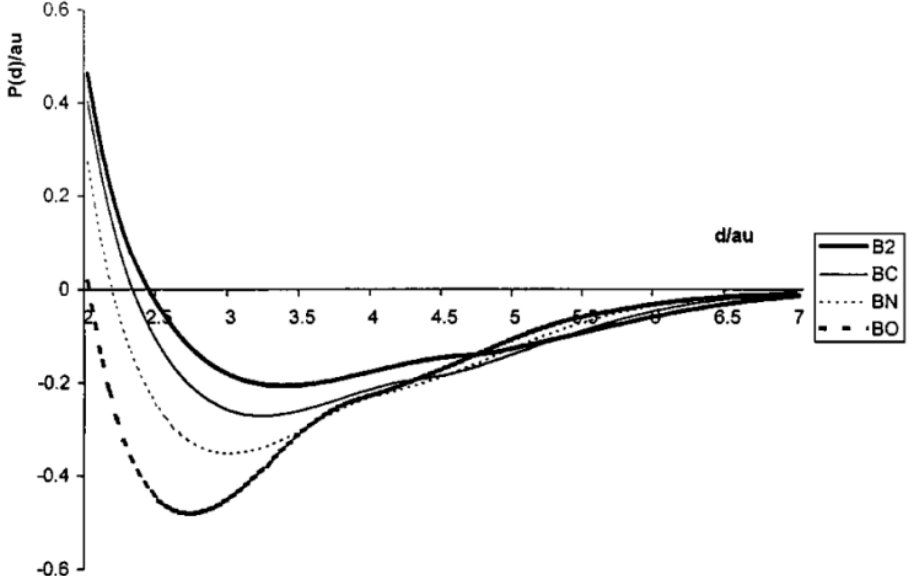
Figure 1. Quasi-classically calculated interatomic potentials for boron-containing diatomic molecules B 2 , BC, BN and BO versus inter-nuclear distances [42]. Copyright (2000), with permission from Elsevier.